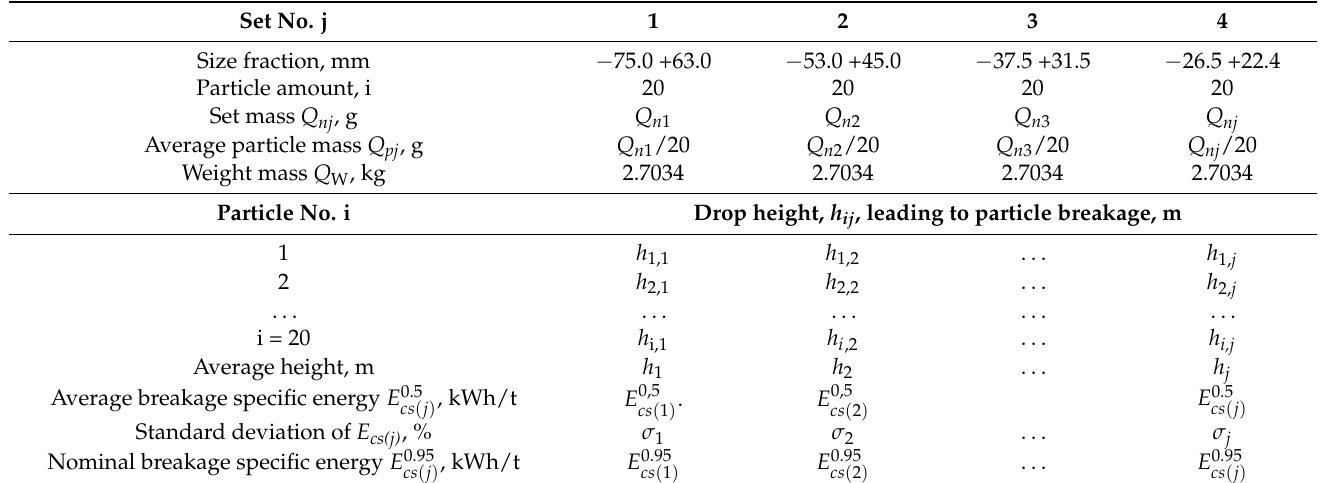
Table 4. Test report for determining the nominal specific energy of particle